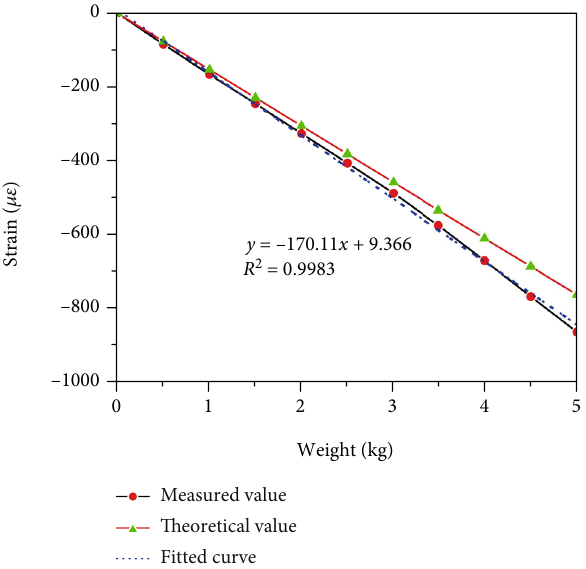
Figure 8: Comparison between measured and theoretical values.